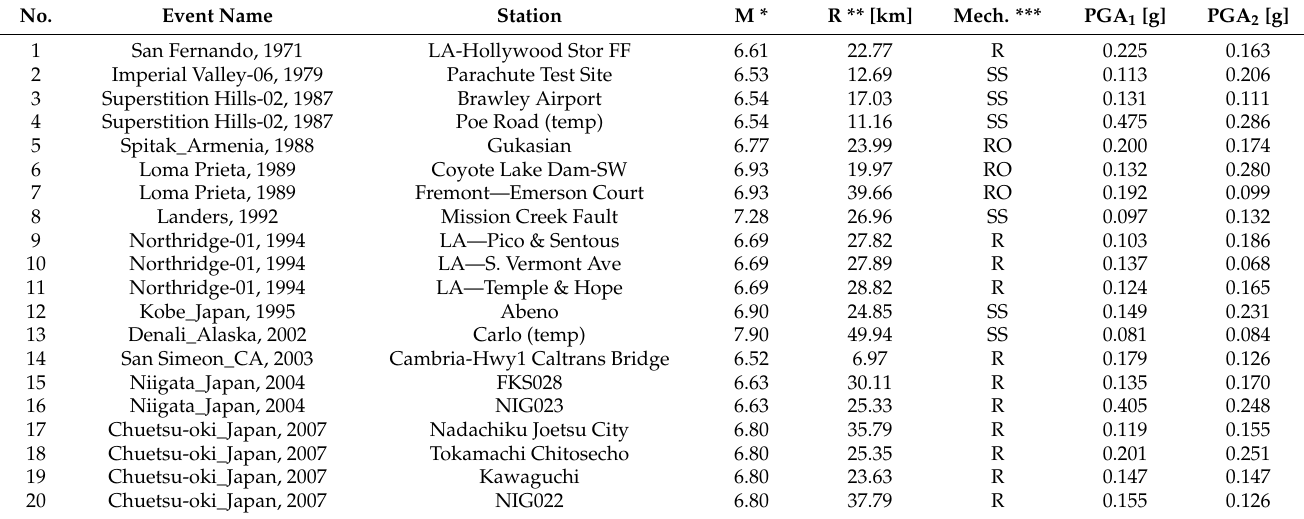
Table 1. Time history records adopted for the analysis (* Moment magnitude; ** Closest distance to fault rupture; *** Fault mechanism, where R: reverse; SS: strike-slip; RO: reverse-oblique).